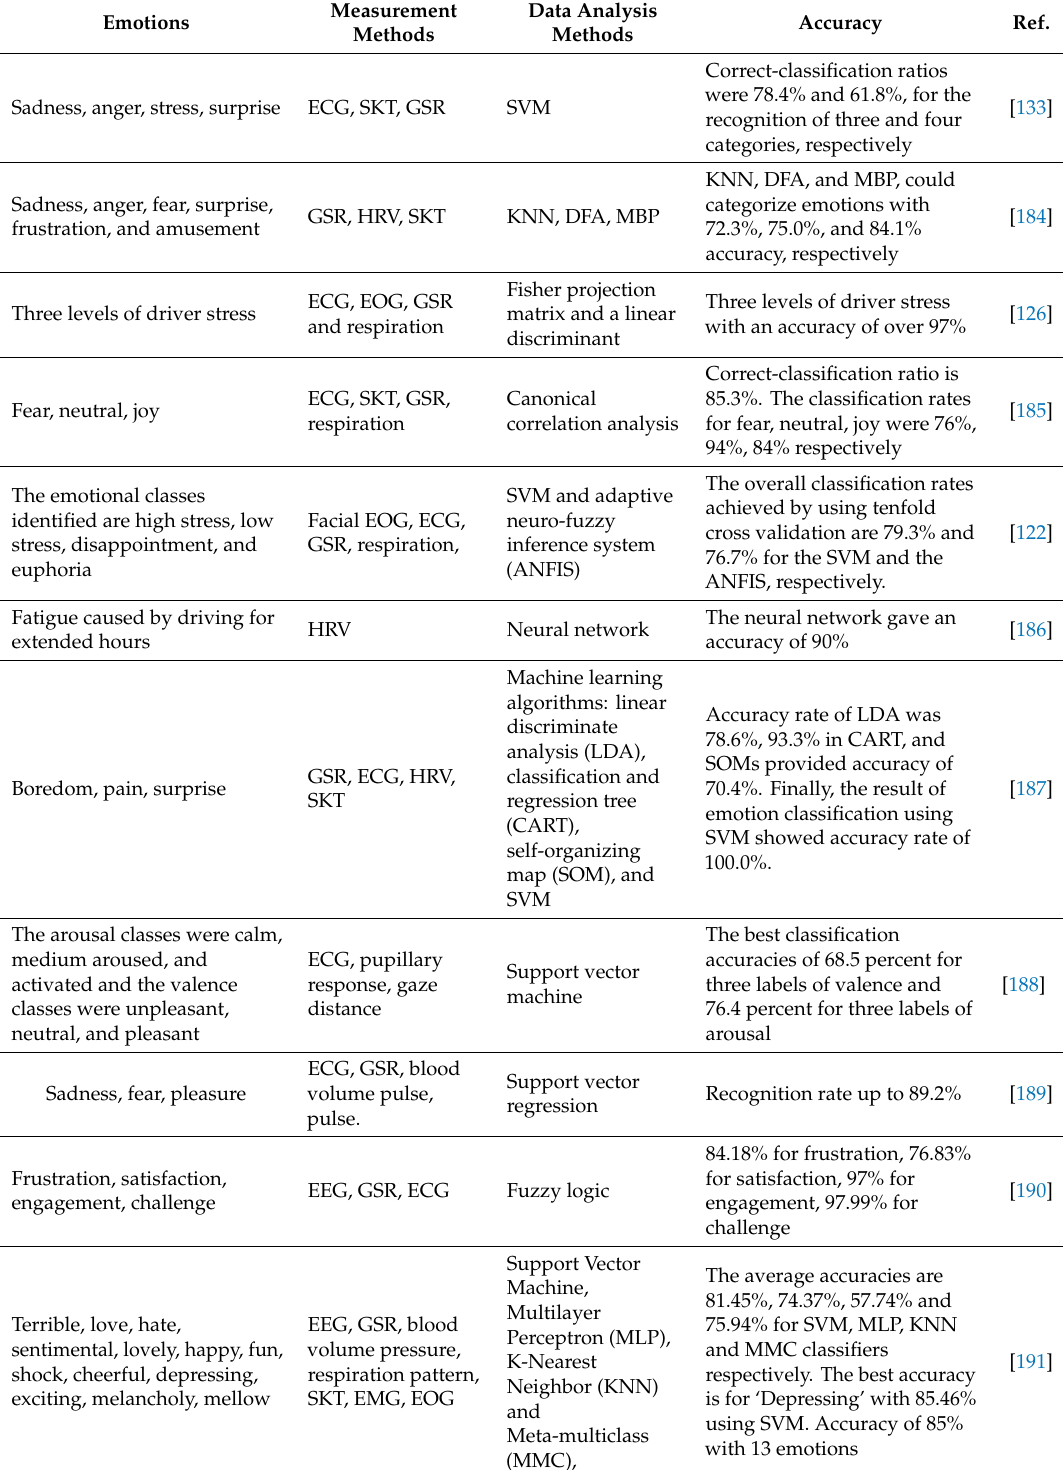
Table 14. Analysis of previous studies on emotion